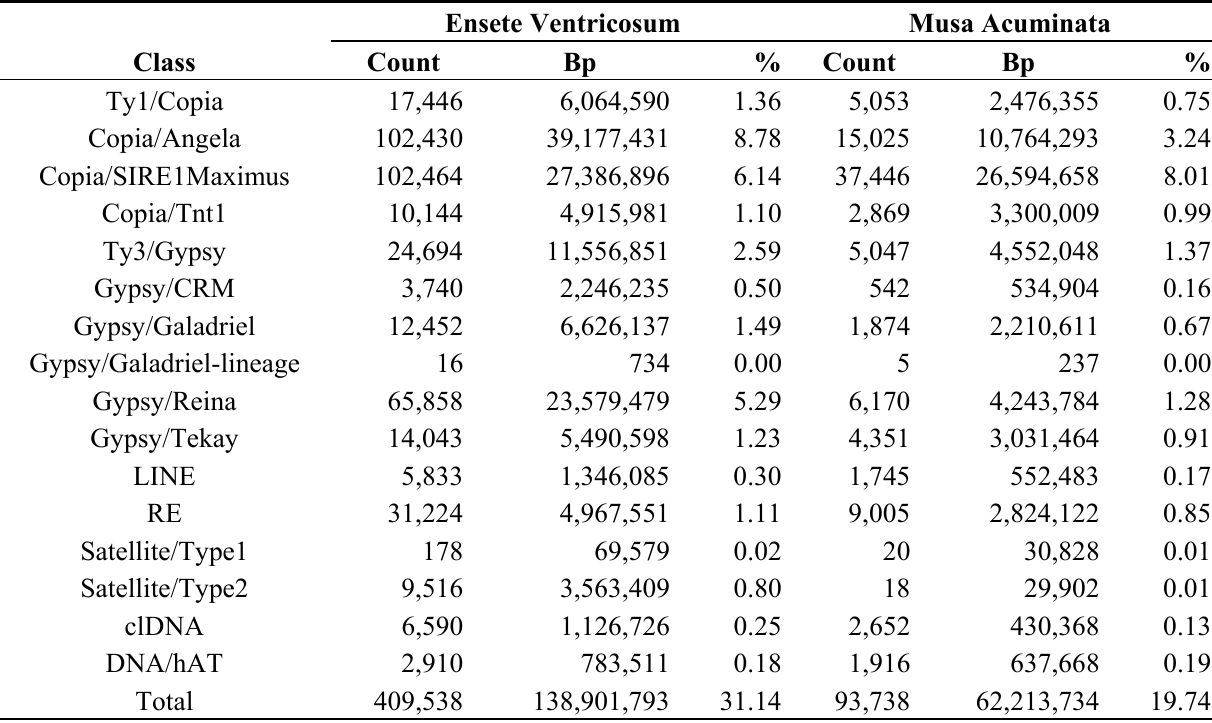
Table 4. Overview and classification of the repeats present in the enset genome and comparison with those in the M. acuminata